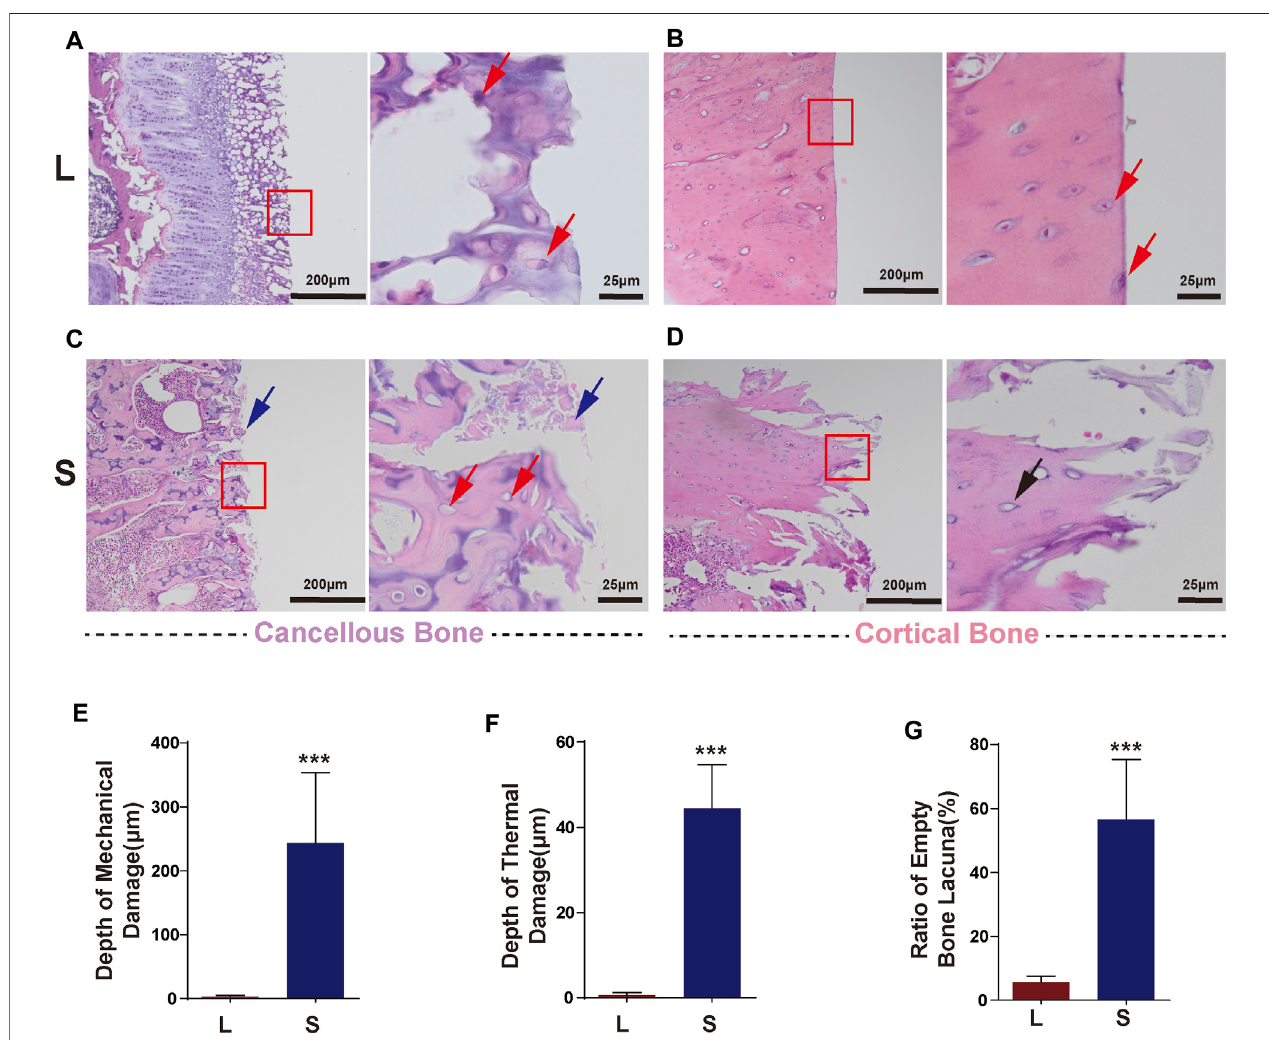
FIGURE 5 | Typical histology images after laser and mechanical saw osteotomy. (A) HE images of laser-cut cancellous bone, with intact cells at the cutting edge indicatedbyredarrows. (B) HEimagesoflaser-cutcorticalbonewithneatcuttingedgesandintactcells.Redarrowsindicatecellsonthecuttingedge. (C) Imagesofthe cancellous bone cut by mechanical sawing, with blue arrows indicating bone chips fi lled with cutting edges and red arrows indicating empty lacunae and crushed trabeculae. (D) HEimages ofthecorticalbonecutbymechanicalsawing.Blackarrowsindicatethedestroyedmarginbone tissueandempty lacunae. (E) Depthof mechanicaldamage. (F) Depthofthermaldamage.Boxesindicatecutoutaftersubsequentmagni fi cation. (G) Emptybonelacunaerate.HE,Hematoxylin – Eosinstaining. *** p < 0.001.